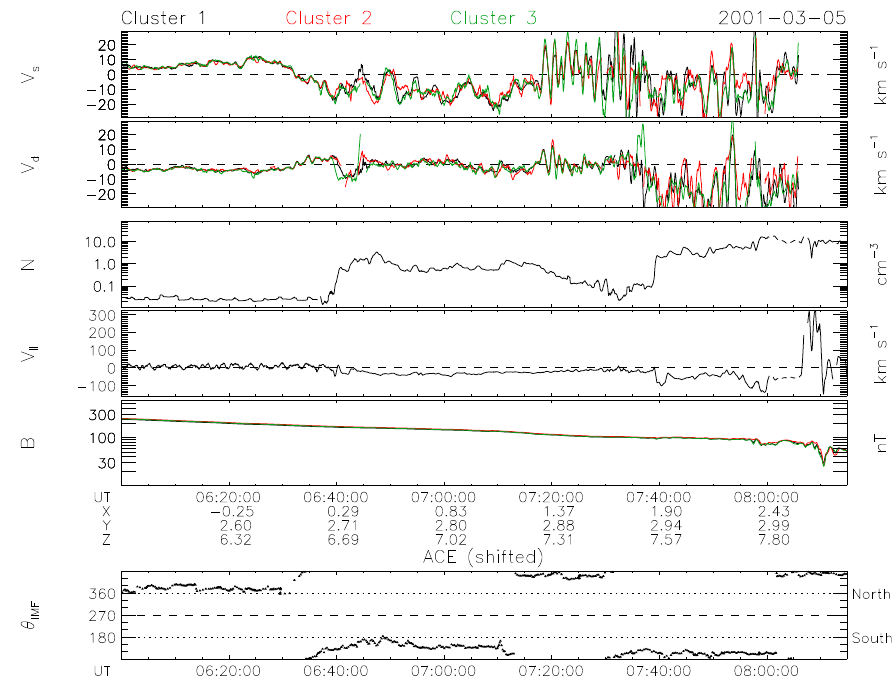
Fig. 6. Data for an outbound pass on 5 March 2001 in the same format as previous figures. The pass is characterized by transitions between piecewise stable IMF directions. The convection essentially follows the IMF, on average, but exhibits well correlated fluctuations with very large amplitudes when entering upward flowing plasma ( V k > 0). The magnetopause is crossed near 08:10